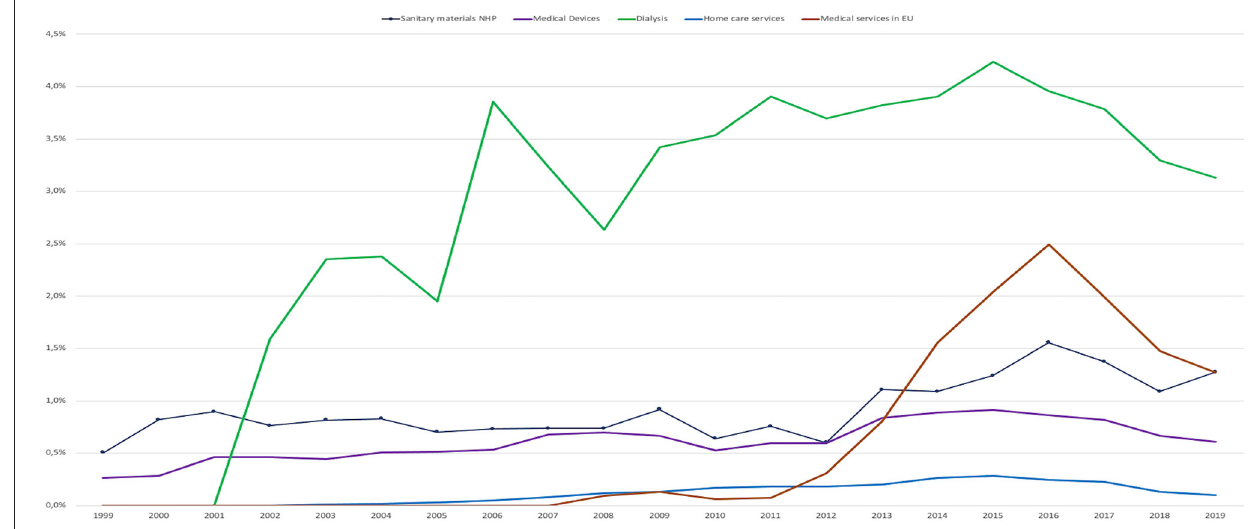
FIGURE 3 | Categories of services with ascendant trends, 1999–2019.